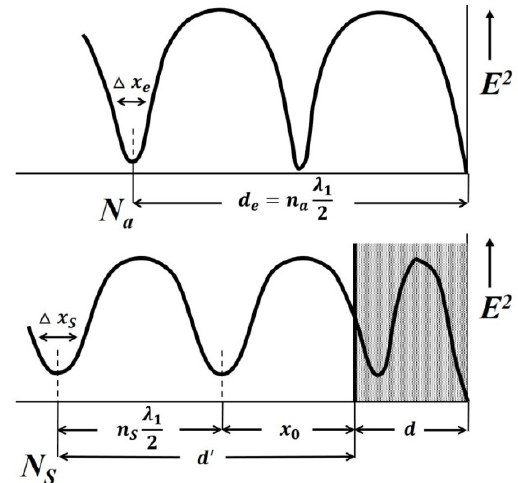
Figure 11. Standing waves in a short-circuited waveguide (upper) and in a short-circuited waveguide with a sample located in it (lower). Adapted from [129] with permission.